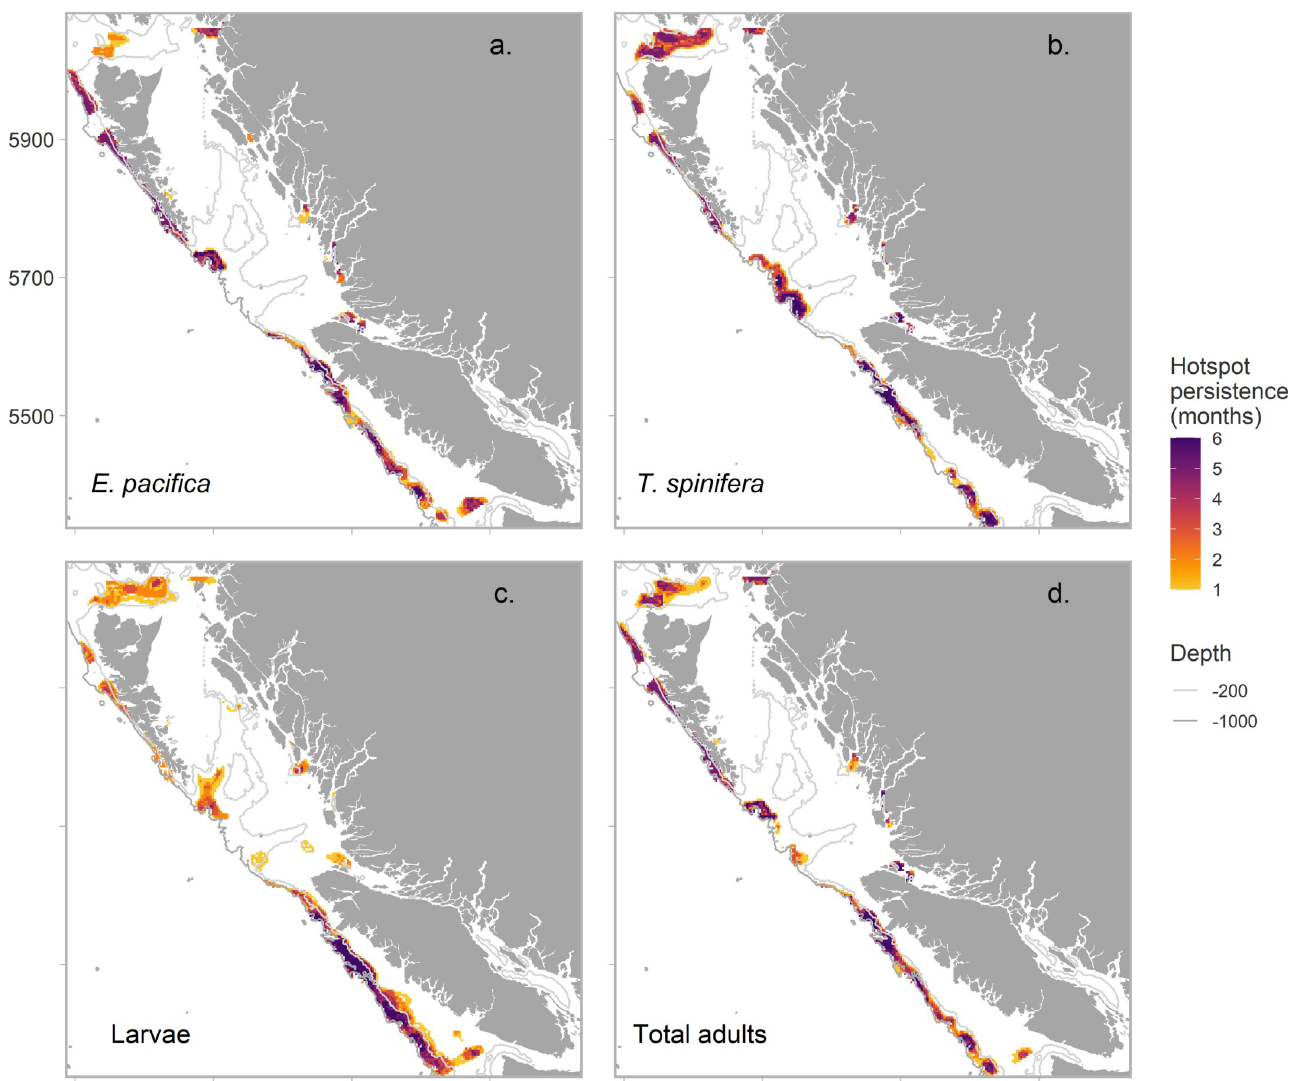
Fig 6. Persistence of 90 th percentile of Z-scores, or hotspots, over the 6-month period examined. 1 = grid cell counted as a hotspot only in one month, 6 = grid cell persistently ‘hot’ in all 6 months, for (a) E . pacifica , (b) T . spinifera , (c) euphausiid larvae and, (d) total euphausiid adults ( E . pacifica + T . spinifera ).